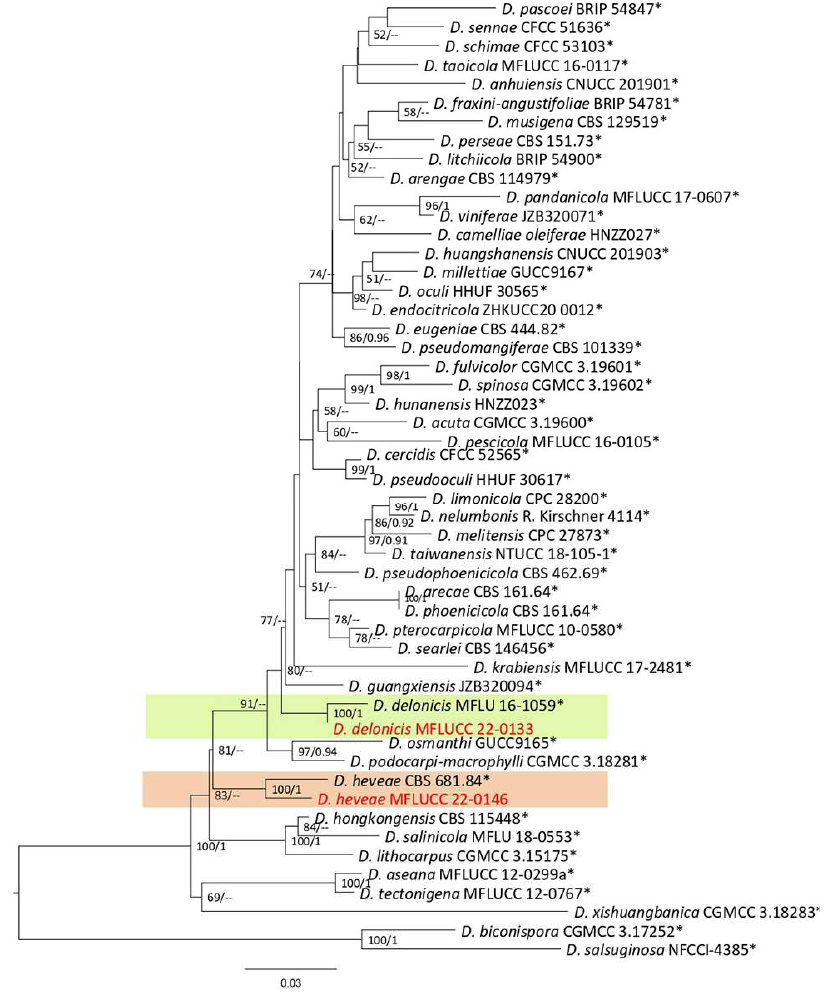
Figure 16. The Diaporthe arecae complex maximum likelihood phylogenetic tree obtained from the combined ITS, tef1 , tub2 , cal , and his3 sequence data. The ultrafast maximum likelihood bootstrap support (%) ≥ 50 and BYPP ≥ 0.90 are shown at the nodes. The ex-type strains are marked with an asterisk. The tree is rooted in D. biconispora (CGMCC 3.17252) and D. salsuginosa (NFCCI - 4385) .